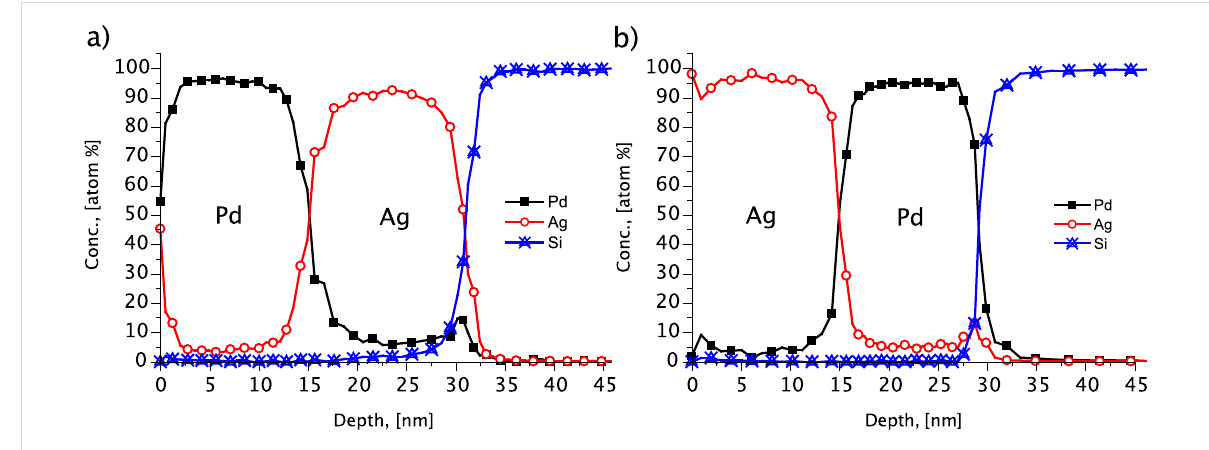
Figure 4: Comparison of depth profiles obtained after 8 h of heat treatment 150 °C. (a) Ag(15 nm)/Pd(15 nm)/substrate, (b) Pd(15 nm)/Ag(15 nm)/ substrate. It can be seen that the reversal of the film sequence leads to the reversal of the inequality of the compositions in the centre of Pd and Ag layers.